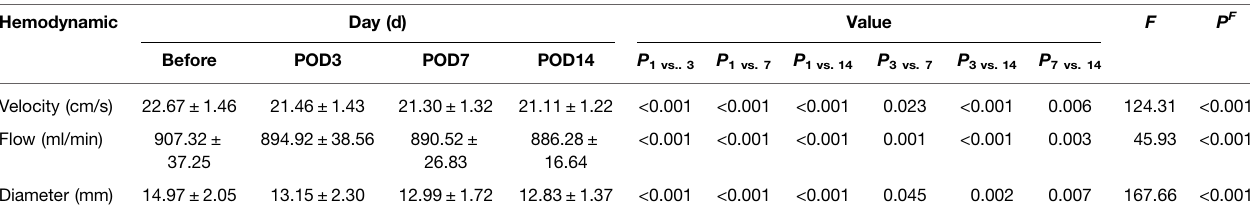
TABLE 1 | Postoperative hemodynamic changes in the portal vein. a Hemodynamic Day (d) Value F P F Before POD3 POD7 POD14 P 3 vs. 14 P 7 vs.